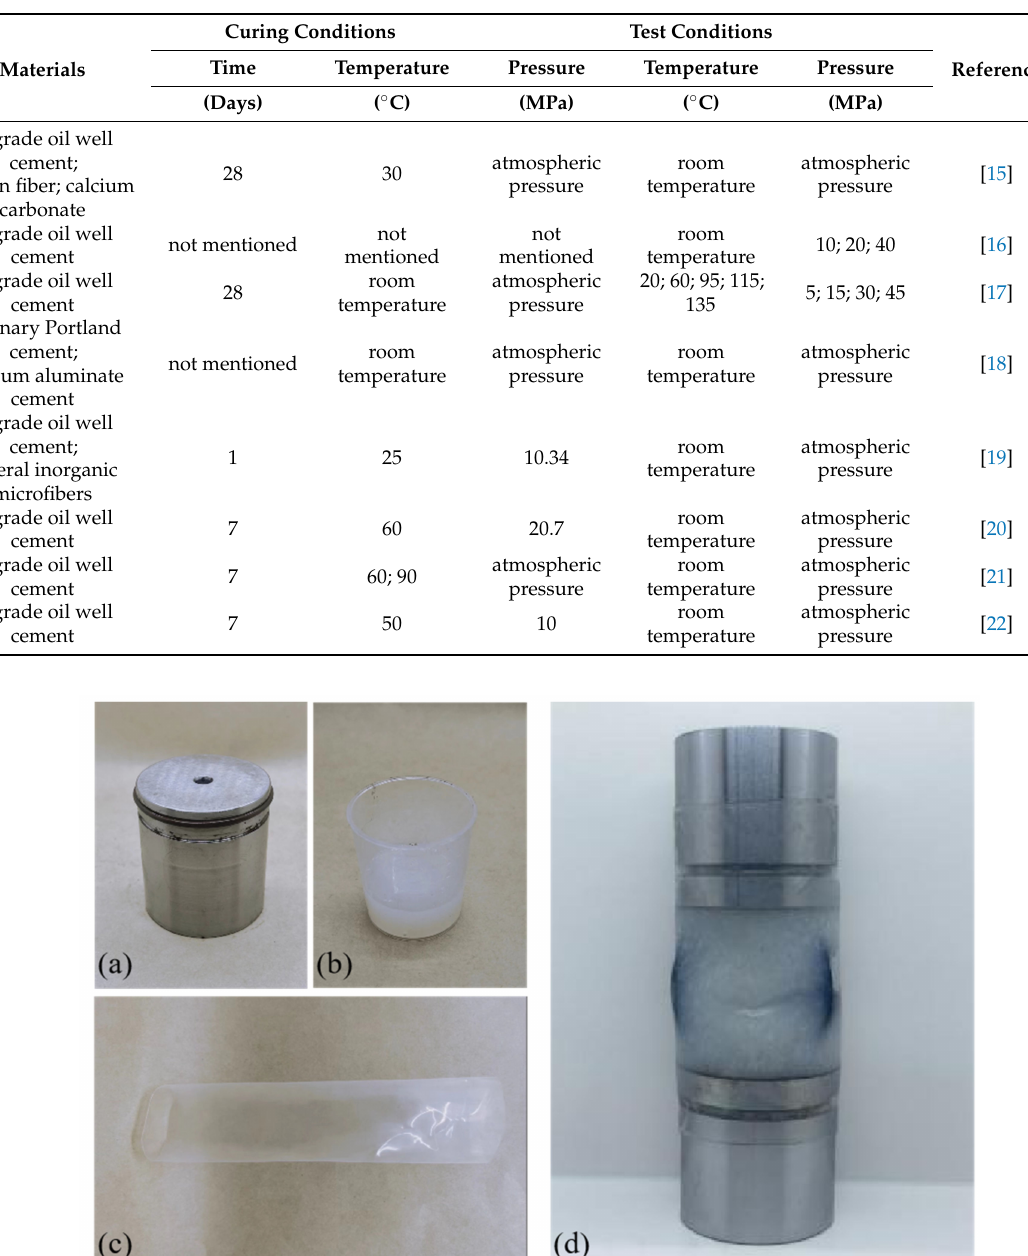
Table 1. Information on test materials and test conditions in some references.